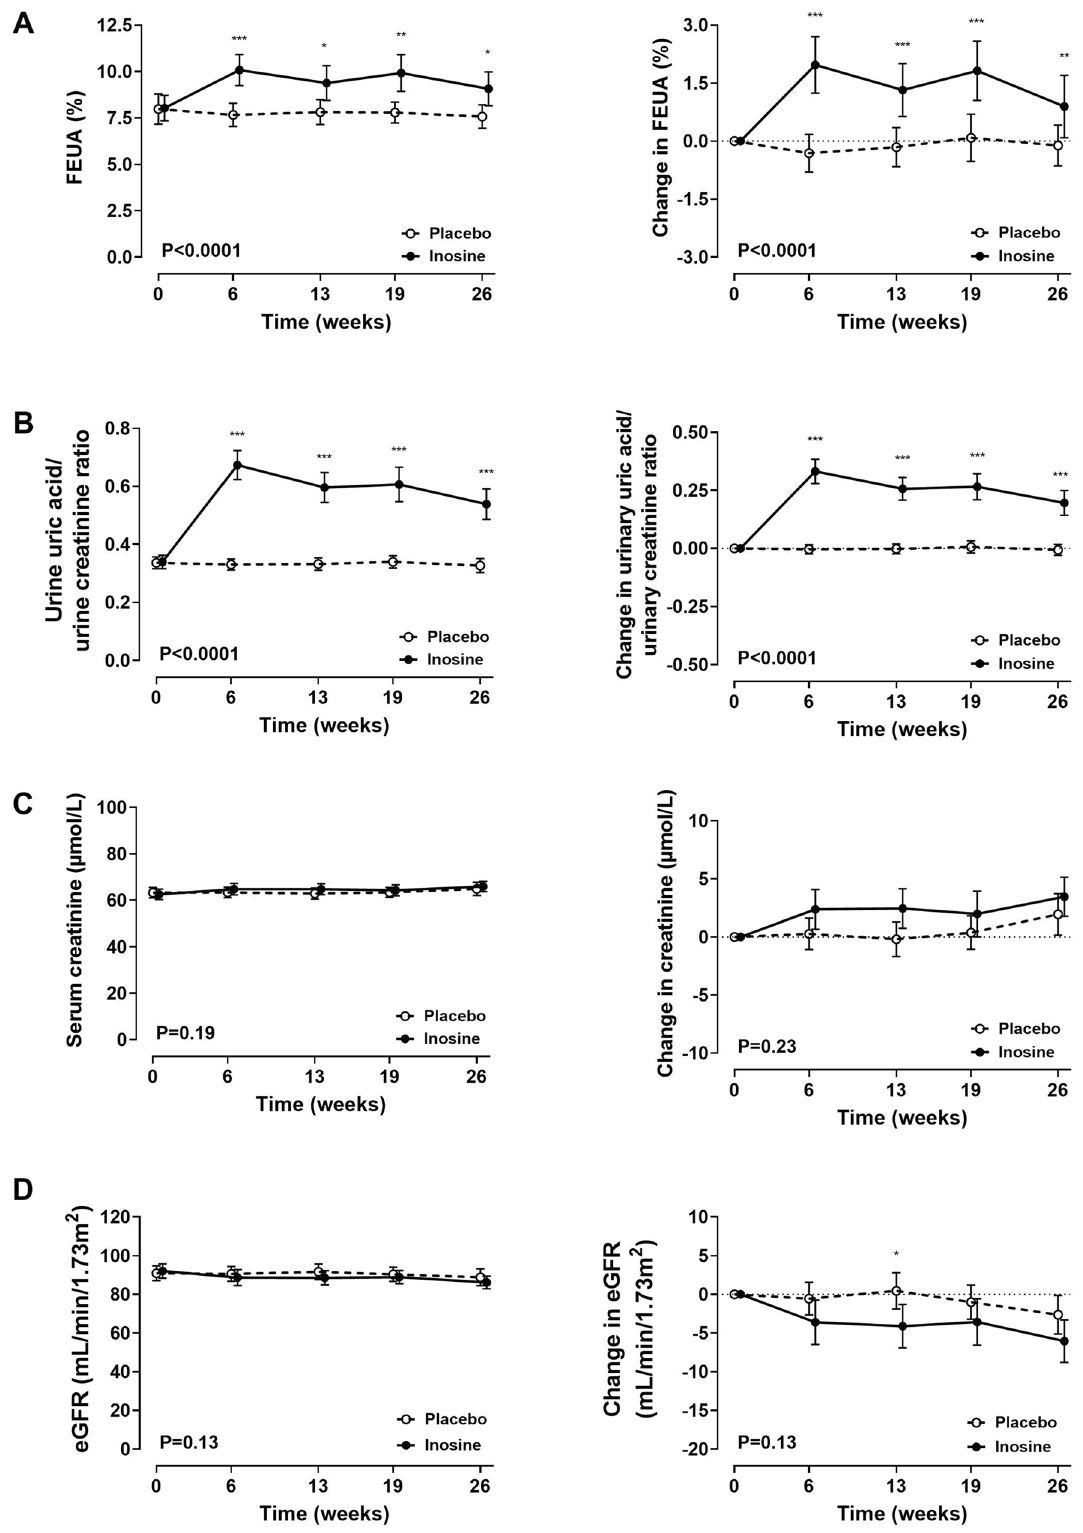
Figure 5. Fractional excretion of uric acid (FEUA), urinary uric acid/urinary creatinine ratio, and measures of kidney function. Absolute values (left panel) and change from baseline (right panel). ( A ) FEUA; ( B ) Urinary uric acid/urinary creatinine ratio. ( C ) Serum creatinine; ( D ) eGFR. Data are shown as mean (95% CI), with P time×treatment . False discovery rate ***P < 0.001, **P < 0.01, *P <